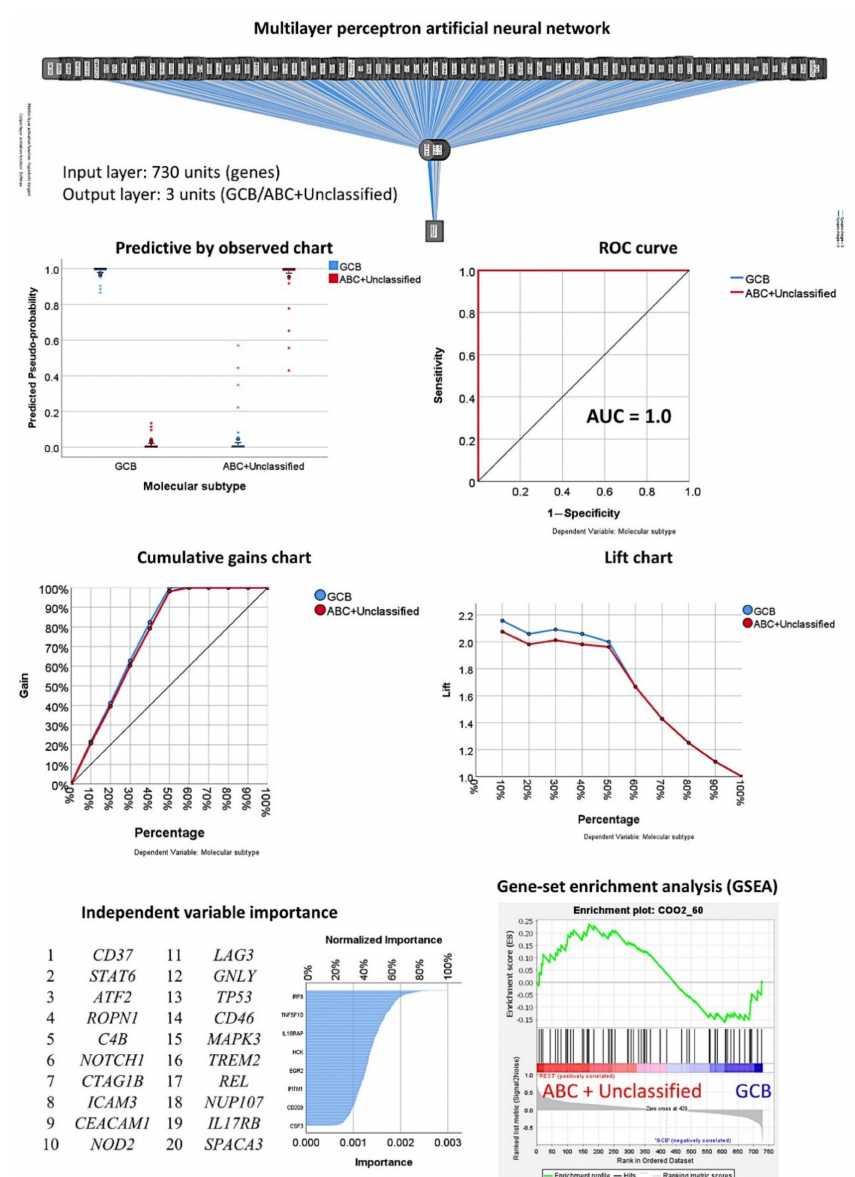
Figure 13. Multilayer perceptron analysis for predicting molecular subtypes (GCB vs.